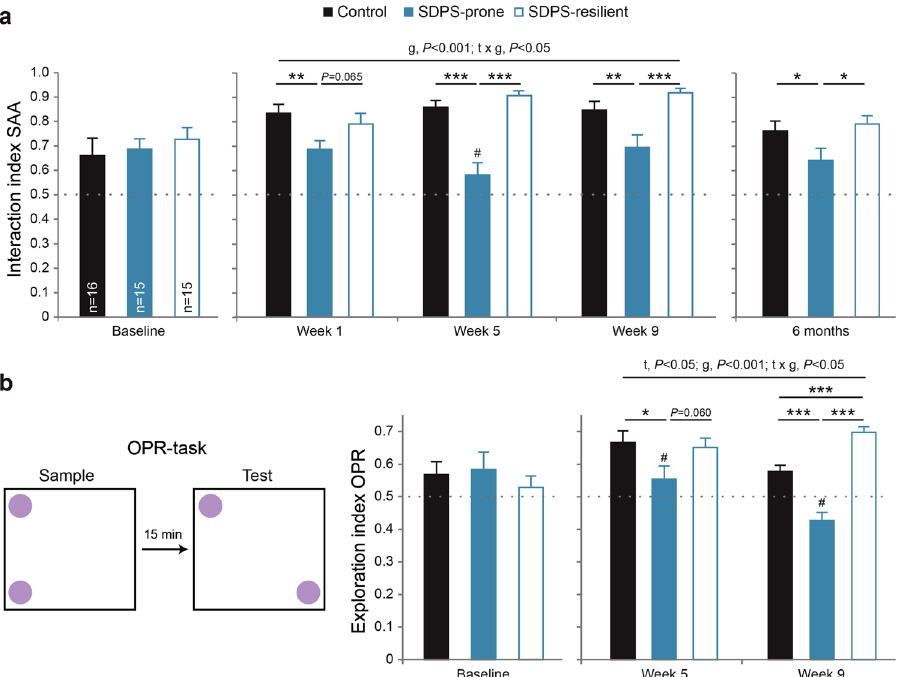
Figure 3. Development of affective and cognitive deficits in SDPS-prone and SDPS-resilient rats. ( a ) Approach- avoidance behaviour was examined in 5 subsequent SAA tests provided during a period of ~6 months ( cf . Fig. 1a). Before defeat (baseline), no pre-existing differences were observed between groups. At SAA w5 , only the SDPS-prone group failed to display preference for the social target. In the months following defeat, SDPS-prone rats showed reduced interaction index vs . controls and SDPS-resilient animals, indicating development of social withdrawal that persisted up to 6 months. ( b ) Left : Schematic representation of the object place recognition (OPR) task, with a 5-minute sampling phase, a 15-minute retention interval and the 5-minute testing phase, in which one of the two identical objects was displaced. Right : Short-term spatial memory was assessed in 3 OPR tests given during a period of 2 months ( cf . Fig. 1a). Prior to defeat no between-group differences were seen. Already at 1 month from defeat, SDPS-prone animals showed inability to retain spatial information for a displaced object, which was exaggerated at the 2-month test. Both control and SDPS-resilient groups displayed intact memory retention. Repeated measures ANOVA main time (t), group (g) and time x group interaction (t x g) effects and pairwise comparisons are indicated. Dotted line represents chance levels (0.50) of interaction (SAA, a ) or exploration (OPR, b ). # No preference for the social target (SAA) or the displaced object (OPR); * P < 0.050; ** P < 0.010; *** P <